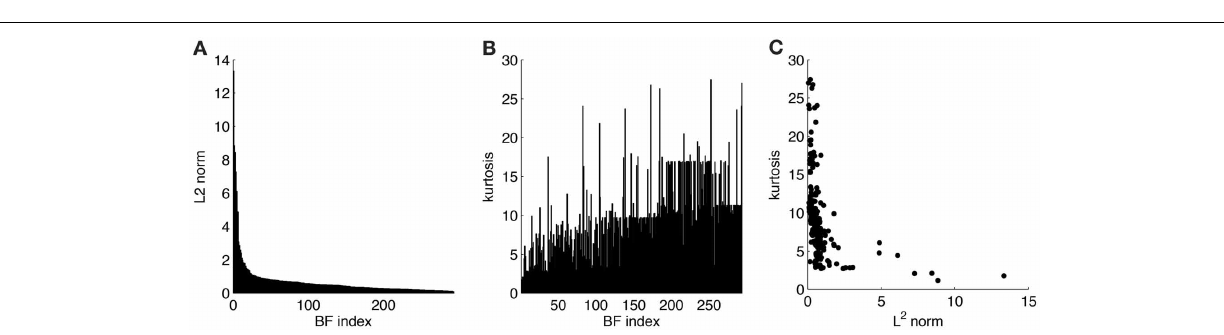
measure of the relative contribution of each basis function to the data. The chromaticities of the individual pixels of each ATA plotted in the cone-opponent color space are shown in Figure 5